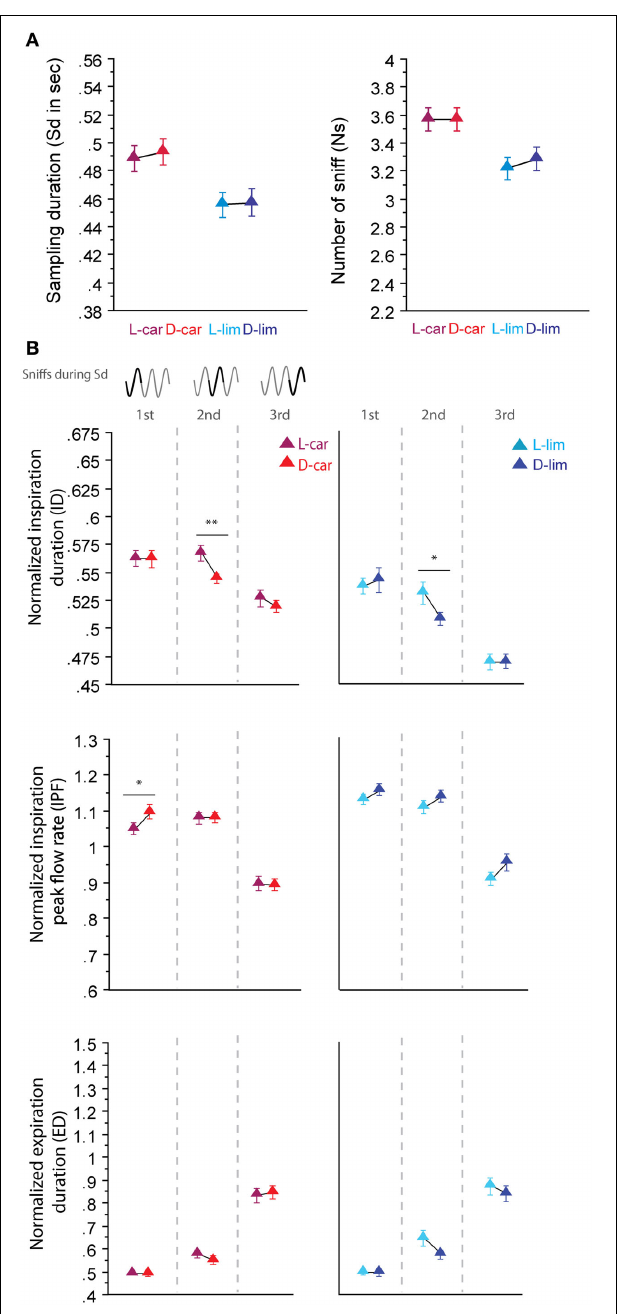
FIGURE 4 | Odorants with similar sorption properties but which are not enantiomers can induce different sniffing strategies. (A) Global sampling parameters (mean ± s.e.m.), Sd (left), and Ns (right), for non-enantiomer odor pairs: hept (green)/mbz (orange) n = 168; cum (brown)/cyc (gray) n = 166. (B) Modulation of respiratory parameters in the first, second, and third cycles for (left to right) hept/mbz and cum/cyc. From top to bottom: mean ( ± s.e.m.) normalized ID, IPF, and ED. Same colors as in (A) . The number of trials for each odorant and cycle in hept/mbz pair is: n cycle 1 = 168, n cycle 2 = 163, and n cycle 3 = 144 and in cum/cyc pair is: n cycle 1 = 166, n cycle 2 = 160, and n cycle 3 = 110. Data were analyzed using a paired t -test; ∗∗ p < 0 . 01; and ∗∗∗ p < 0 .